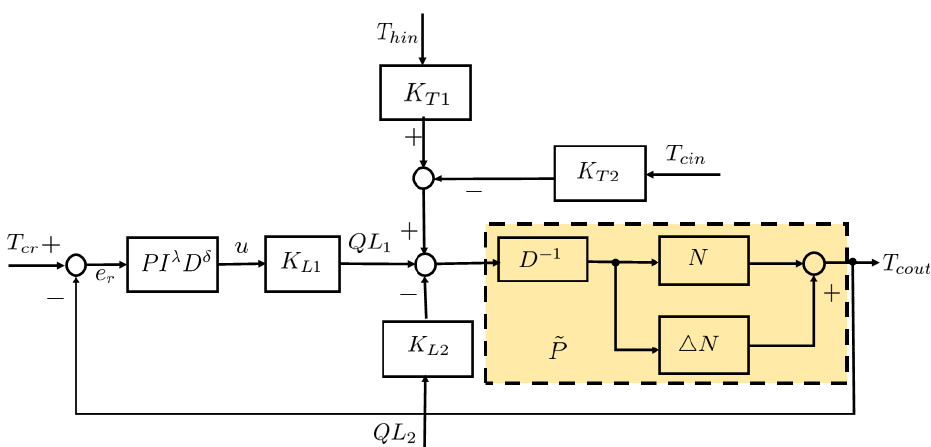
Figure 10. FOPID controller with operator.